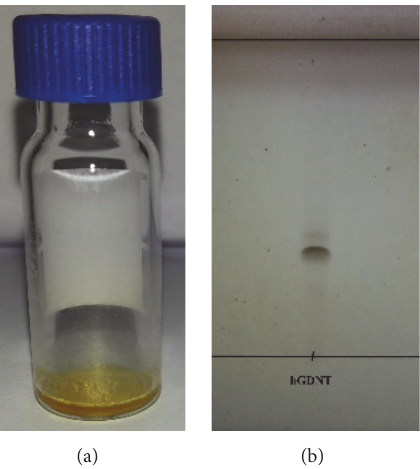
Figure 4: (a) Appearance of purified hGDNT (16.9mg). (b) HPTLC of hGDNT with CHCl 3 :MeOH (90:10v/v) as a mobile phase and silica gel as a stationary phase.